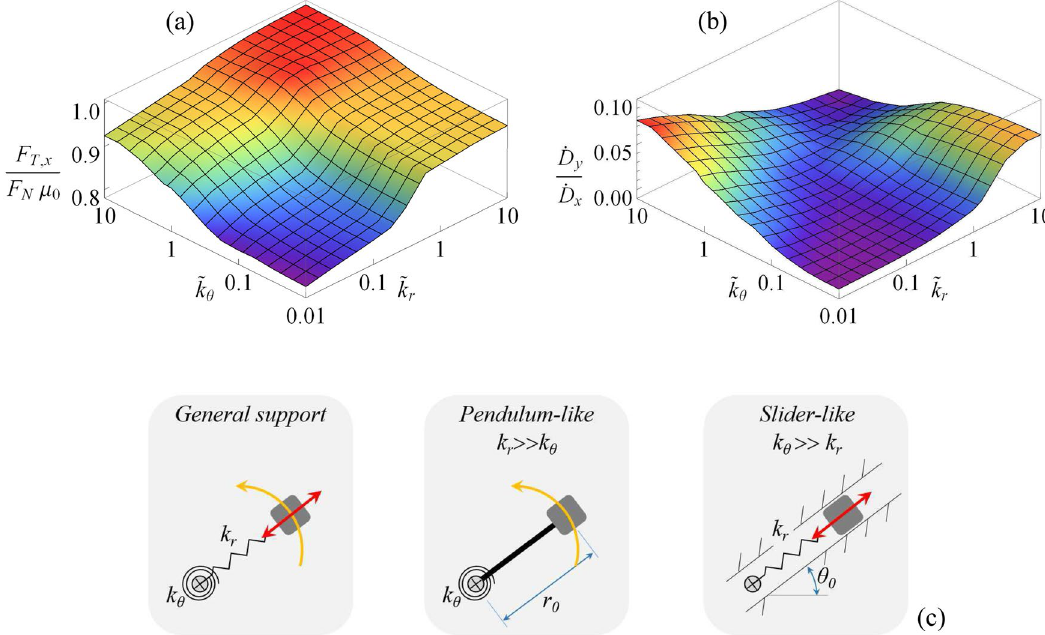
Figure 5. The 3D representations of ( a ) the apparent normalized friction force F T , x /µ 0 F N and ( b ) the ratio ˜ k ˜ k ˙ D ˙ D θ stiffness. ( c ) shows a schematic of the qualitative behavior of r and torsional y / x as functions of the radial pendulum and slider dynamic regimes. Results are for ˜ F N = 1 . Notably µ 0 = µ( V 0 )